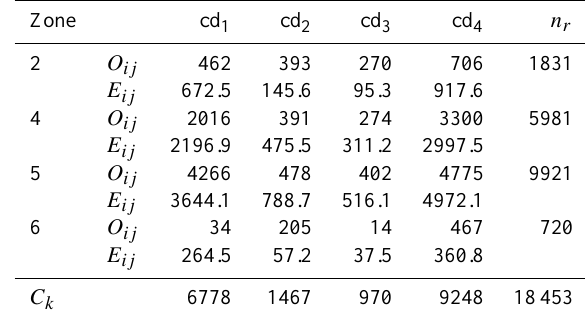
Table 14. Summary of results obtained in the Kolmogorov–Smirnov test for the seismic condition. Zones compared 2 and 4 n 1